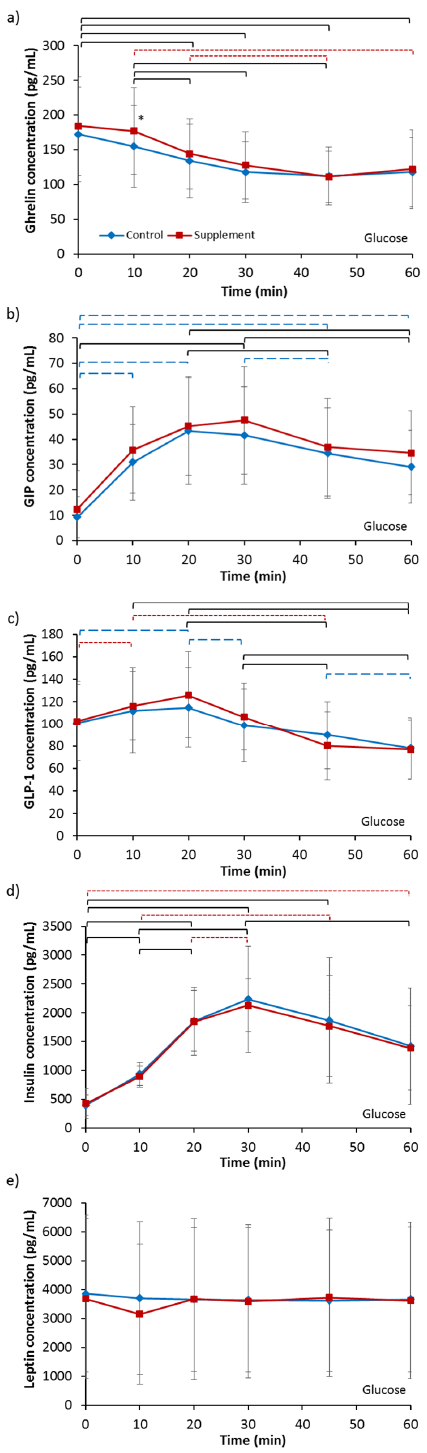
Figure 3. Serum concentrations of ( a ) ghrelin; ( b ) GIP; ( c ) GLP ‐ 1; ( d ) insulin and ( e ) leptin for 60 min following ingestion of a 6% glucose solution. Treatments were control without fructose supplementation and with three days of supplementation with 120 g fructose per day. * Significantly greater for supplement compared to control ( p < 0.05). Brackets denote significant difference between time ‐ points, blue long dashed for control trial only, red small dashed for supplement trial only and black solid for both trials ( p < 0.05). Values are mean ± standard deviation.